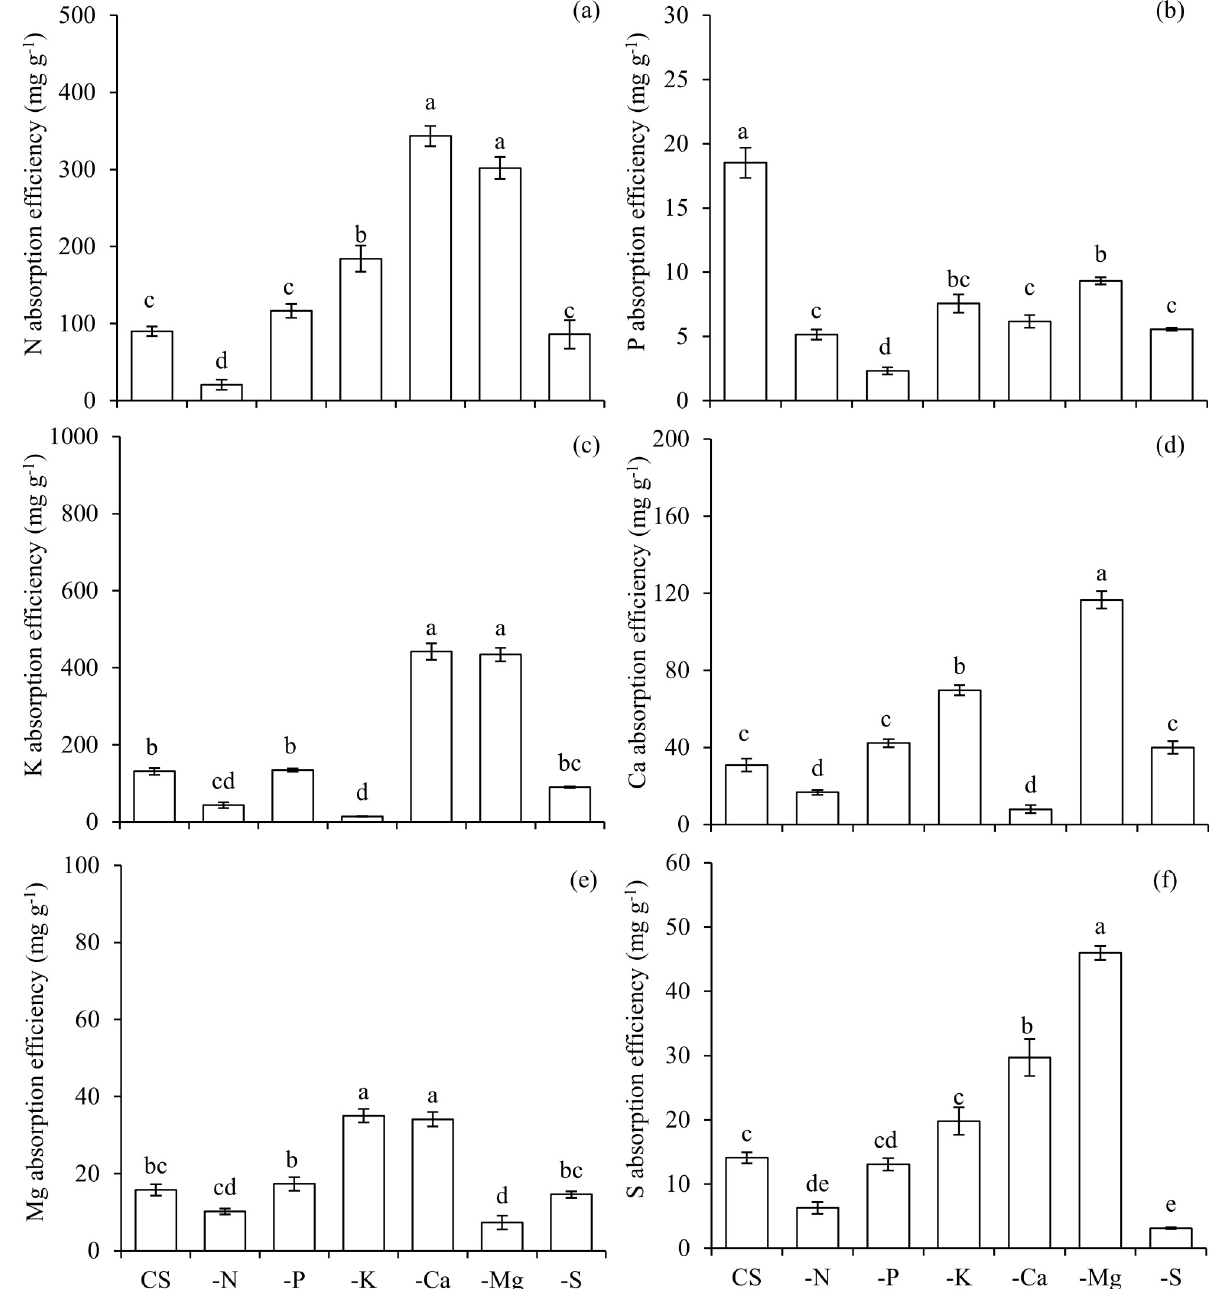
Fig 3. Absorption efficiencies of nitrogen (N) (a), phosphorus (P) (b), potassium (K) (c), calcium (Ca) (d), magnesium (Mg) (e), and sulfur (S) (f) in scarlet eggplants in complete solution (CS), and under the omission (-) of macronutrients ( − N, − P, − K, − Ca, − Mg, and − S). Means followed by the same letter in each bar did not differ from each other by the Tukey’s test (p � 0.05). Bars represent the standard error of the